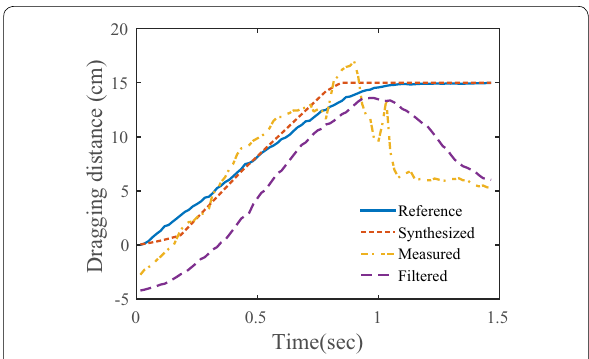
Fig. 6 Qualitative results. The comparative plot of different motion profiles during horizontal drag gesture execution under unstable tracking conditions. The synthesized motion data is smooth and best replicates the reference motion pattern. By comparison the measured motion data has high fluctuations making the vibrotactile feedback unrealistic and